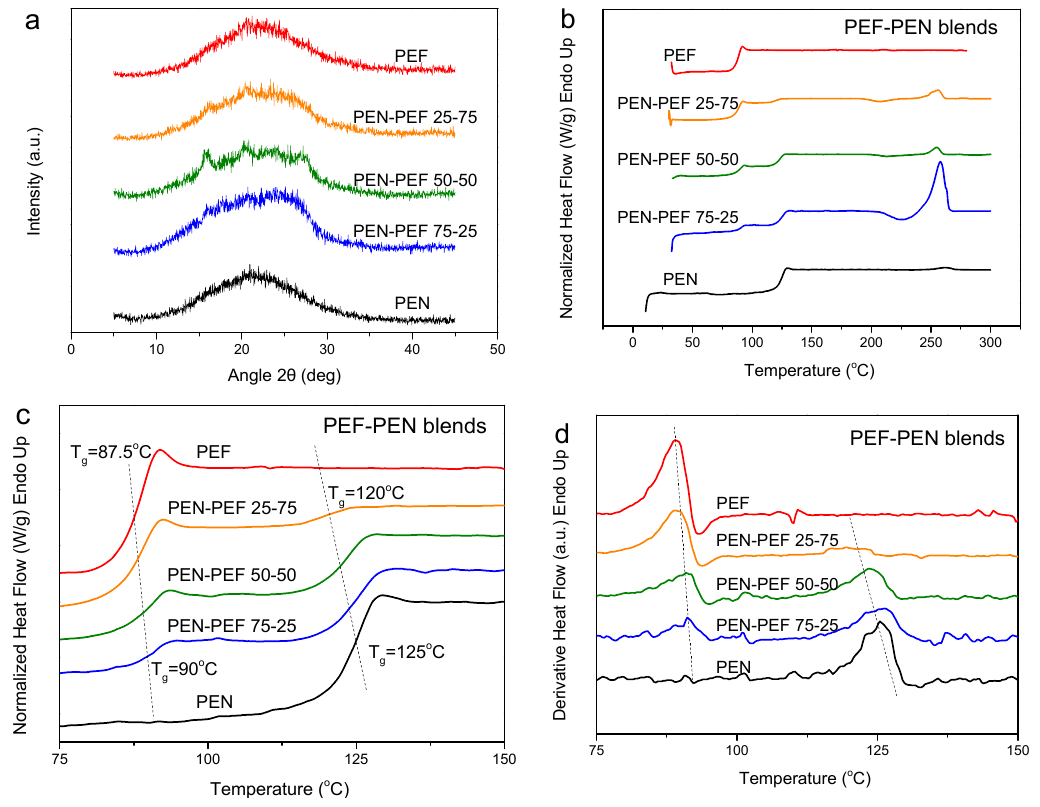
Figure 1. ( a ) WAXD patterns for as received PEN–PEF blends, ( b ) DSC heating thermograms, ( c ) details of DSC thermograms in the T g region and ( d ) derivative heat flow for melt-quenched PEN–PEF blend samples.